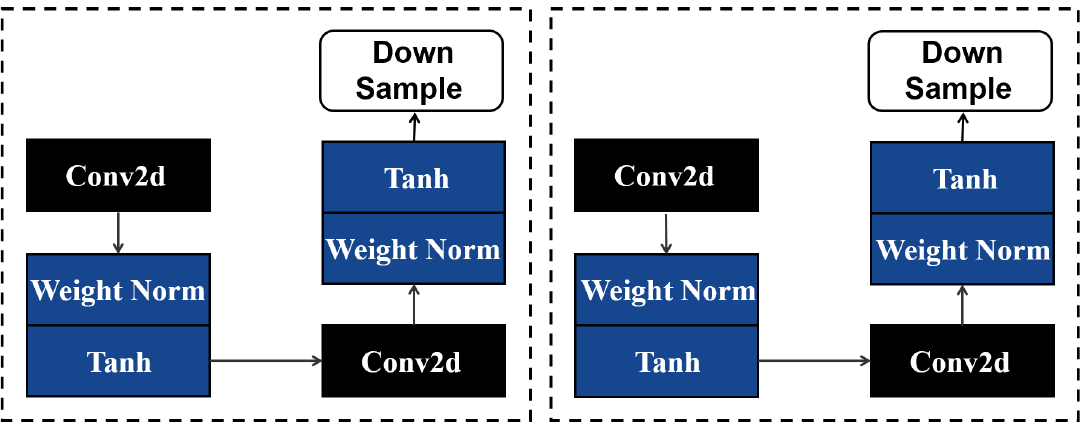
Figure 12. Multilayer residual structure.